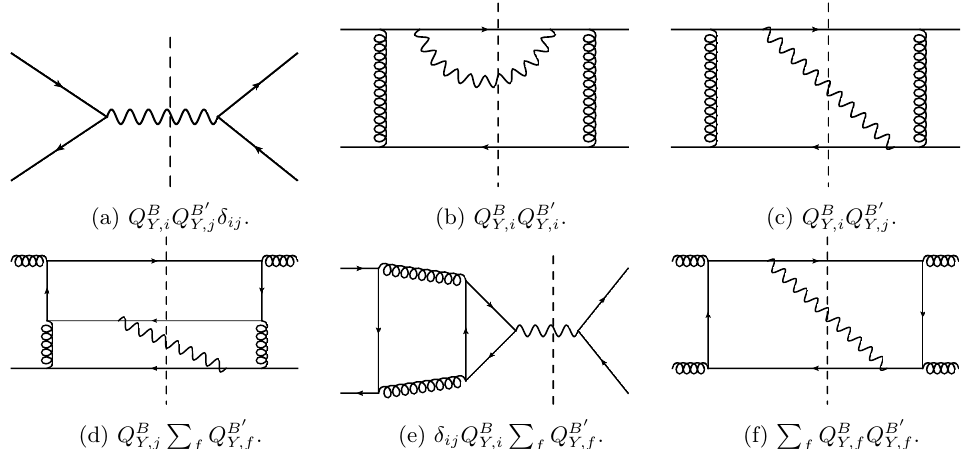
Figure 3. Representative diagrams for different charge structures appearing in the NCDY cross section. The diagrams show interference diagrams where the vertical dashed line represents the final state phase space cut. Solid, wavy and curly lines represent propagating quarks, gauge bosons and gluons